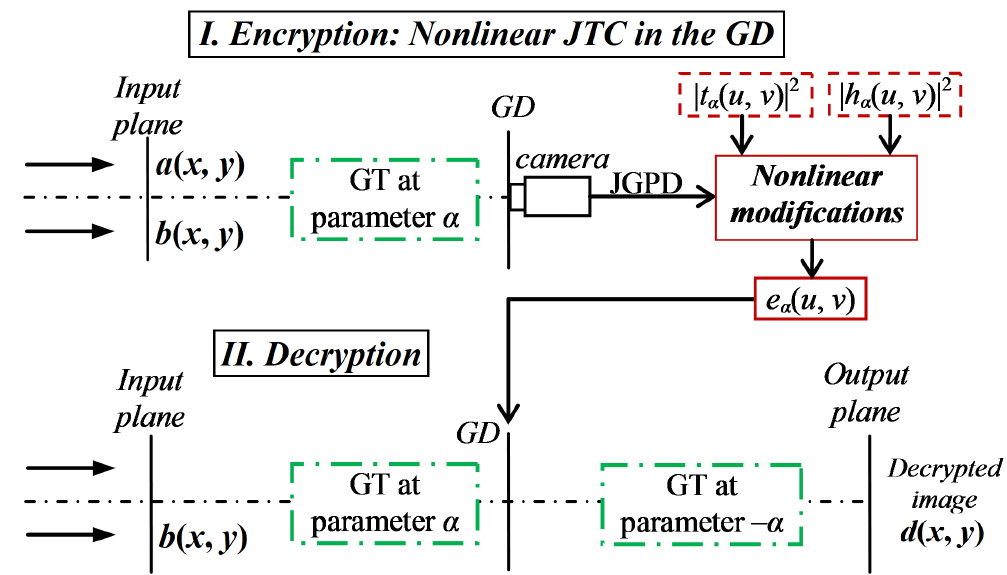
Figure 1. Schematic diagram of the optical system. The encryption system is a nonlinear joint transform correlator (JTC) architecture that uses a gyrator transform (GT) and the decryption system performs two successive GTs